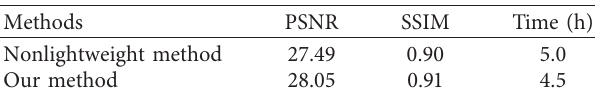
Figure 11: 4 × super-resolution results of networks with and without lightweight parameters: (a) tower top without lightweight parameters; (b) tower top with lightweight parameters; (c) tower body without lightweight parameters; (d) tower body with lightweight parameters. Table 3: Performance analysis of the lightweight method.